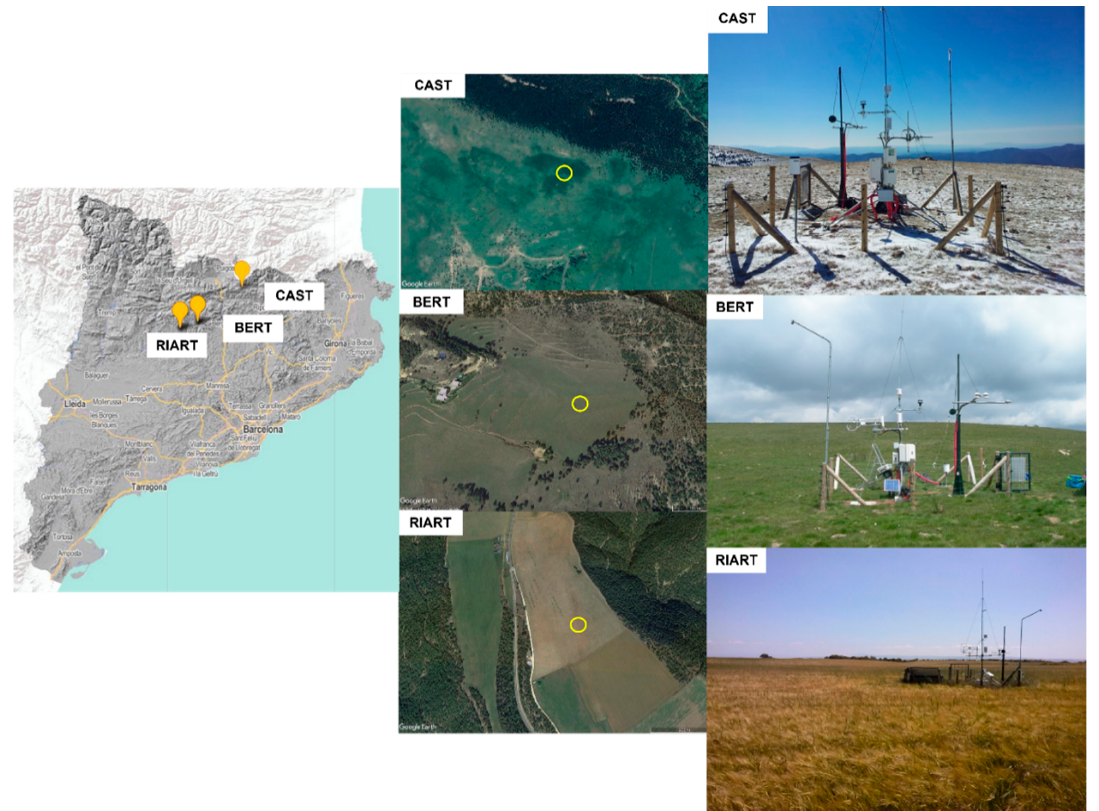
Figure 1. From left to right: Location of the study sites (source of the map: Institut Cartogràfic i Geològic de Catalunya, https://www.icgc.cat/, accessed on 10 January 2021); aerial view (source: googlemaps); and pictures of the eddy covariance flux stations (source: Laboratory of Functional Ecology and Global Change (ECOFUN), http://ecofun.ctfc.cat/, accessed on 10 January 2021). The more detailed aerial view of the study sites can be seen in the Annex S1 of the Supplementary Material. Table 1. Site names, coordinates, altitude, mean annual temperature (MAT), source: eddy covari- ance flux stations, data from the period 2012–2020; mean annual precipitation (MAP), source: Servei Meteorologic de Catalunya (https://en.meteocat.gencat.cat/, accessed on 14 August 2022, see the de- tails in Annex S2); soil type according to the NRCS/USDA nomenclature [24]; and management re- gime.